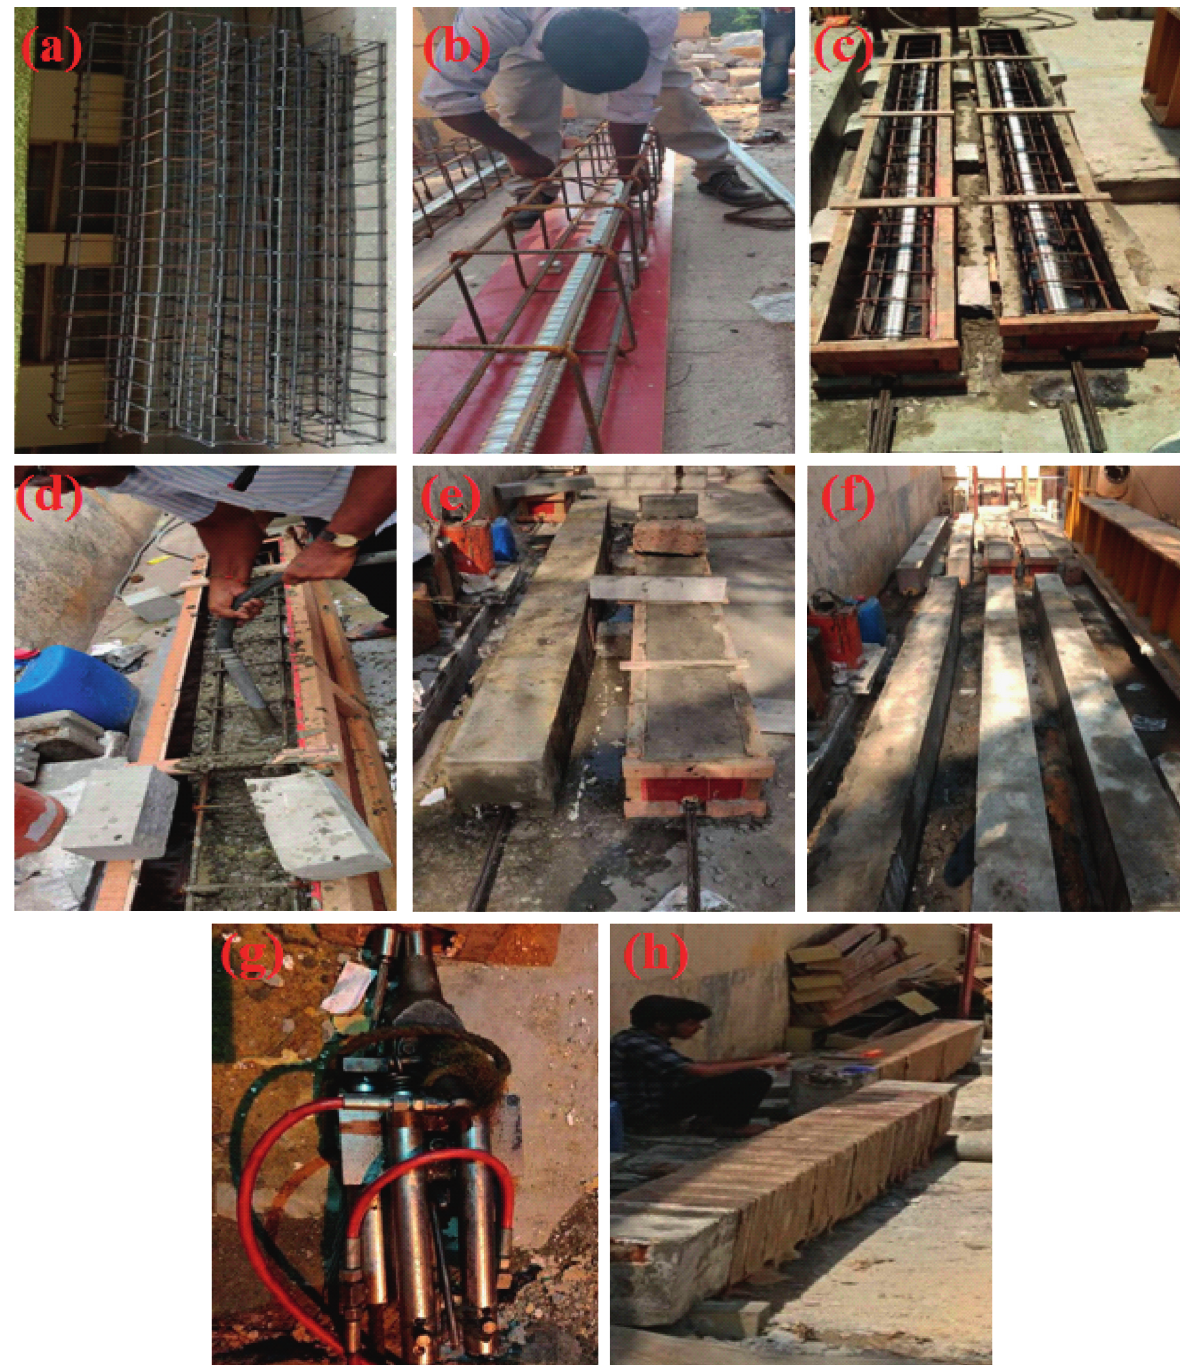
Figure 2: Procedure adopted. (a) Steel reinforcement. (b) Anchorage. (c) Sheathing pipe installation. (d) Pouring concrete and compacting with vibrator. (e) Beams to solidify in the mold for 24hrs. (f) Beams after burr removal. (g) Stressing with hydraulic jack. (h) Jute mat wrap. Table 2: Experimental